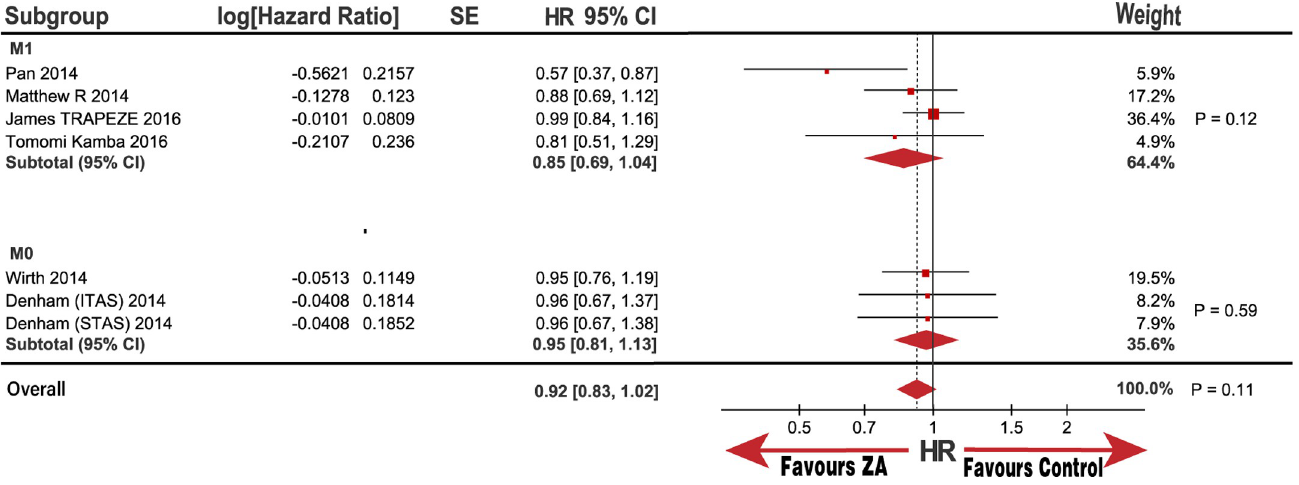
Fig 4. Forest plot with hazard ratio (HR) of OS in subgroup of M1 and